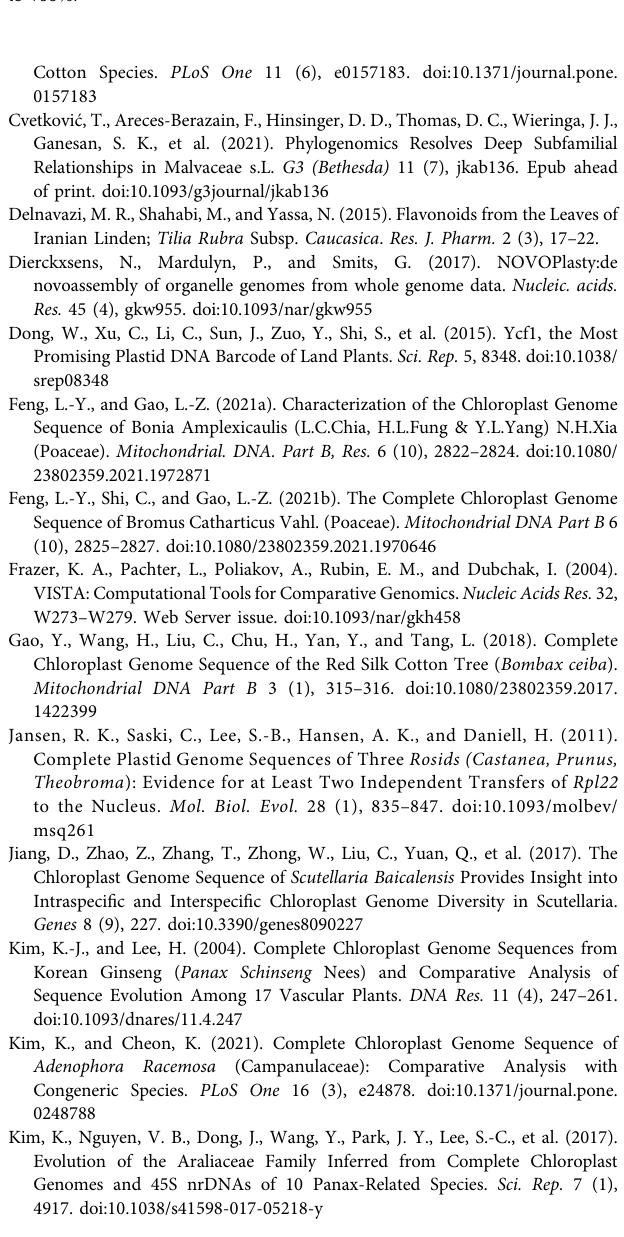
Supplementary Figure S1 | A comparison of the cp genomes among the 12 Tilia species. Gray arrows above the alignment indicate gene orientation. Genome regions are color-coded as exons, UTRs and non-coding sequences (CNSs). The vertical scale indicates the percentage of identity, ranging from 50% to